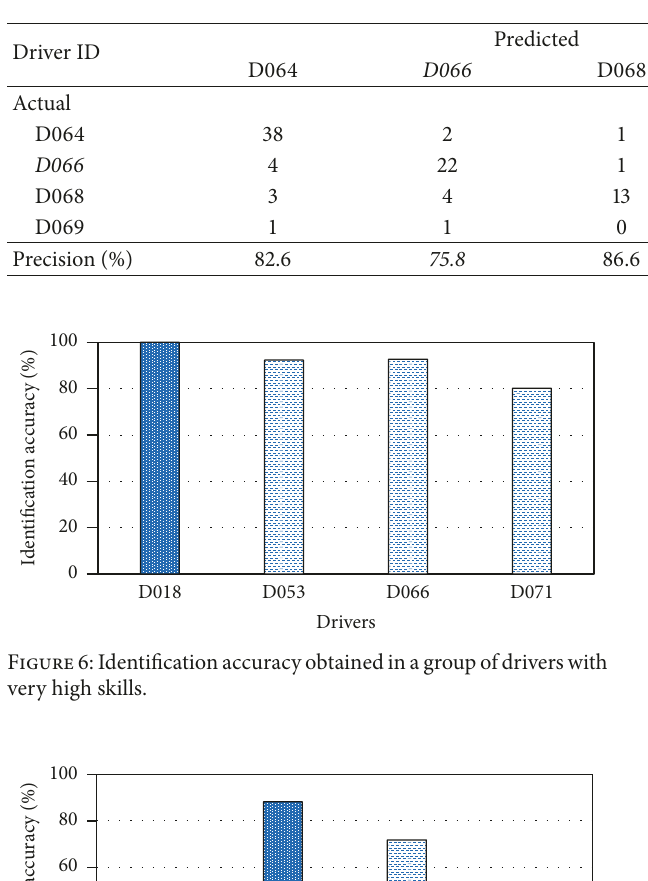
Table 10: Confusion matrix on group 6 (G6) of drivers.